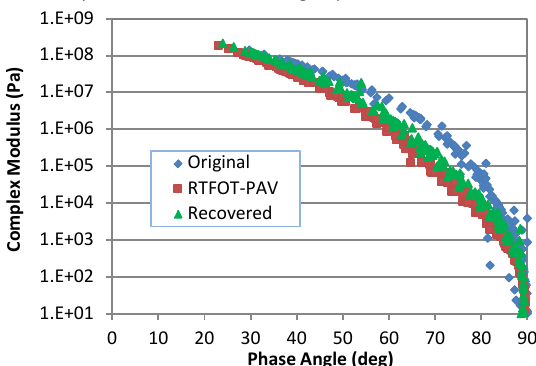
Figure 5. Aging characteristics using FTIR showing the oxidation of the carbonyl and sulfoxide functional groups.